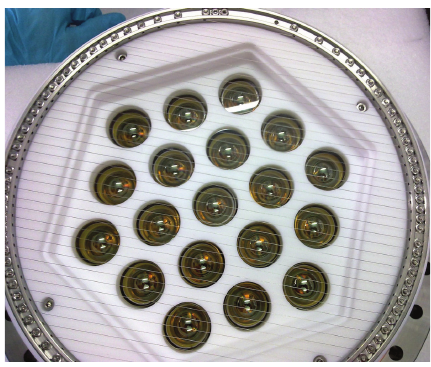
Figure 25: The energy plane of NEXT-DEMO, equipped with 19 Hamamatsu R7378A PMTs.